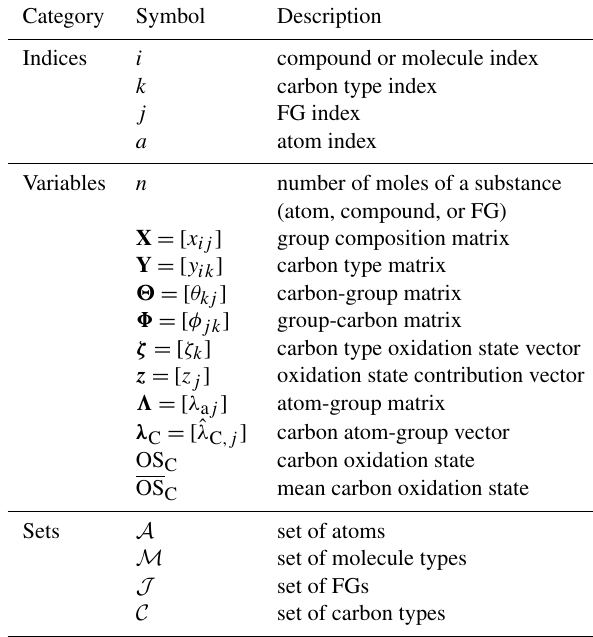
Table B1. Mathematical symbols used in the paper and their de-